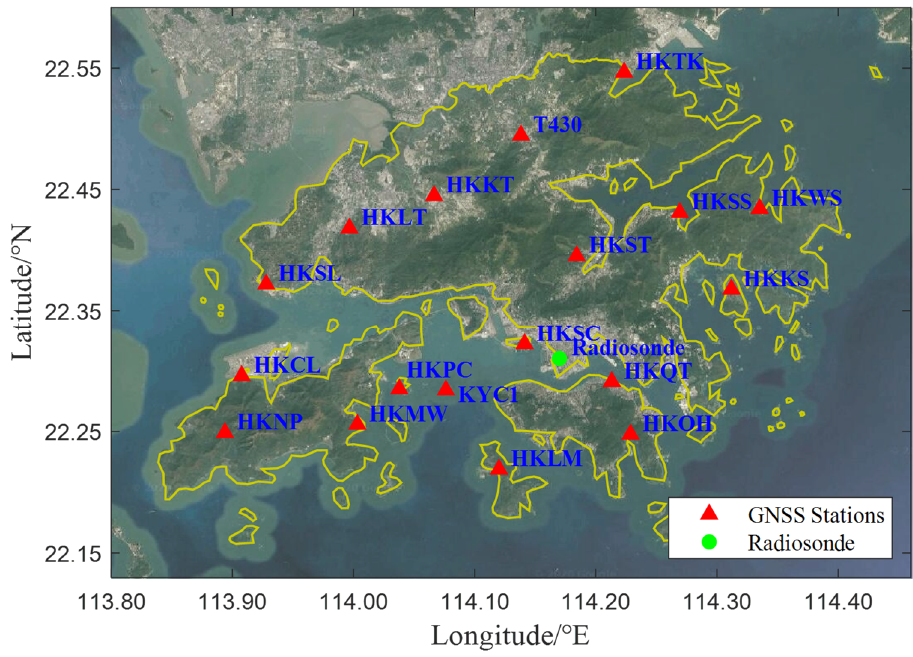
Figure 5. Geographic distribution of 18 GNSS stations (red triangles) and 1 radiosonde (RS) station (green circle) in Hong Kong (HK).